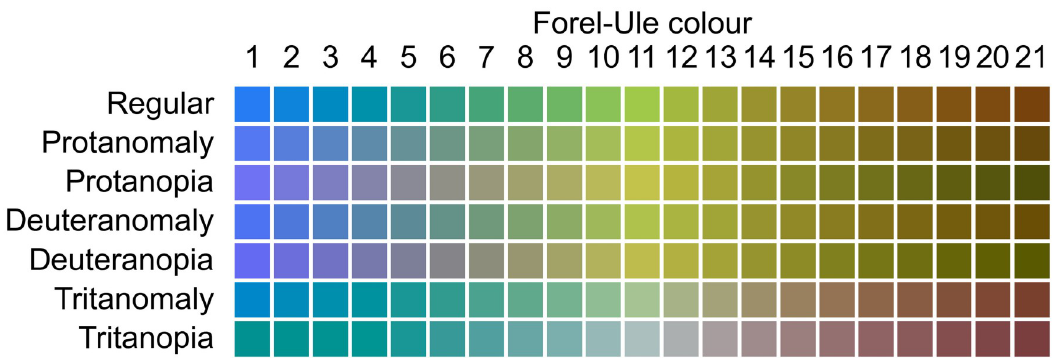
Fig 2. Apparent Forel-Ule colours with regular and deficient colour vision. The (modified) XYZ coordinates were adapted to a D65 illuminant, then converted to the sRGB colour space and gamma expanded [1] for visualization purposes. The perceived colours may vary depending on monitor or printer settings and the reader’s own colour vision. Readers who cannot distinguish between the colours shown here may benefit from taking a colour vision test; many variants are freely available online. The anomalous examples correspond to k =